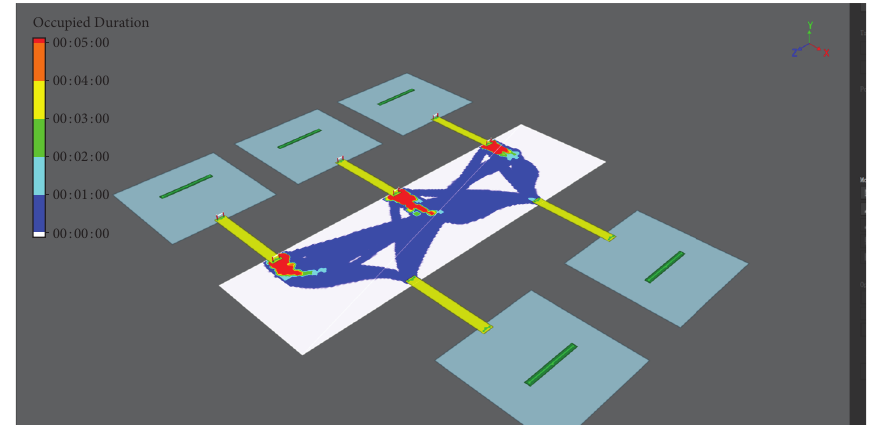
Figure 8: The heat map of Massmotion simulation passenger waiting area occupancy